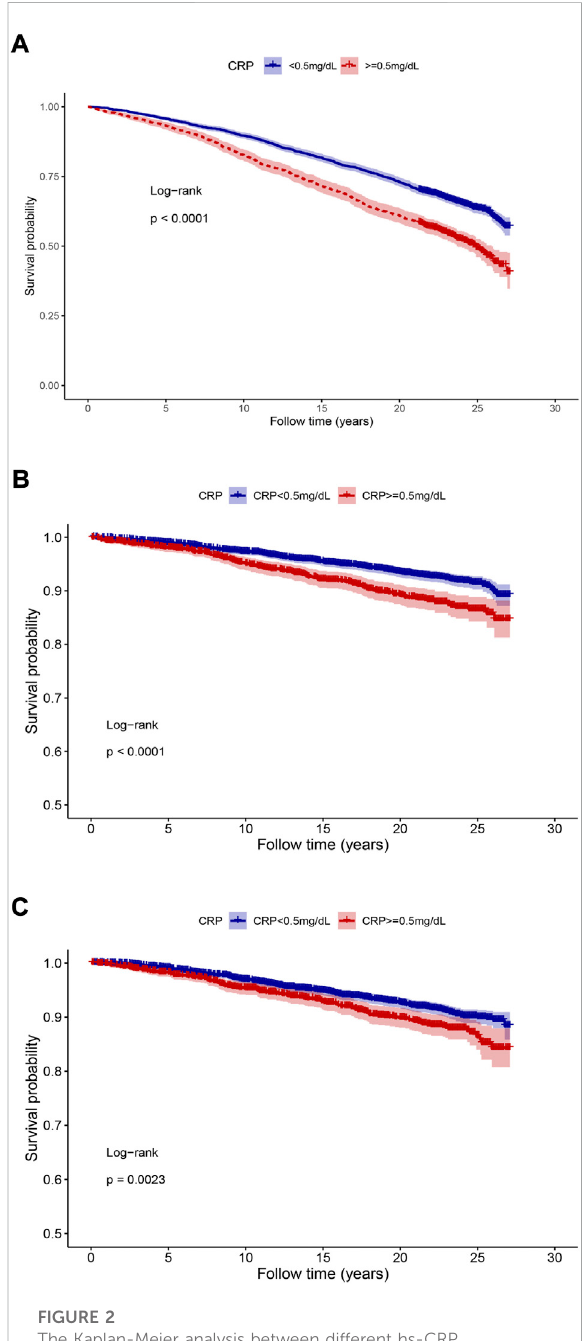
FIGURE 2 The Kaplan-Meier analysis between different hs-CRP concentrations and mortality. (A) All-cause mortality; (B) cardiovasculardiseasesrelatedmortality; (C) malignantneoplasms related mortality. The p- values were calculated by the log- rank test.